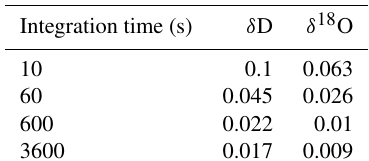
Table 3. Selected Allan deviation values (‰) for a 7h analysis of isotopically homogenous water on the CRDS-CFA system.